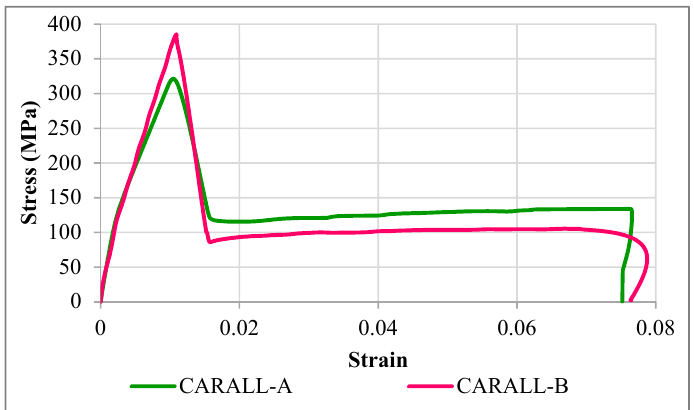
Figure 24. Tensile behavior of CARALL FMLs without veil cloth layers.